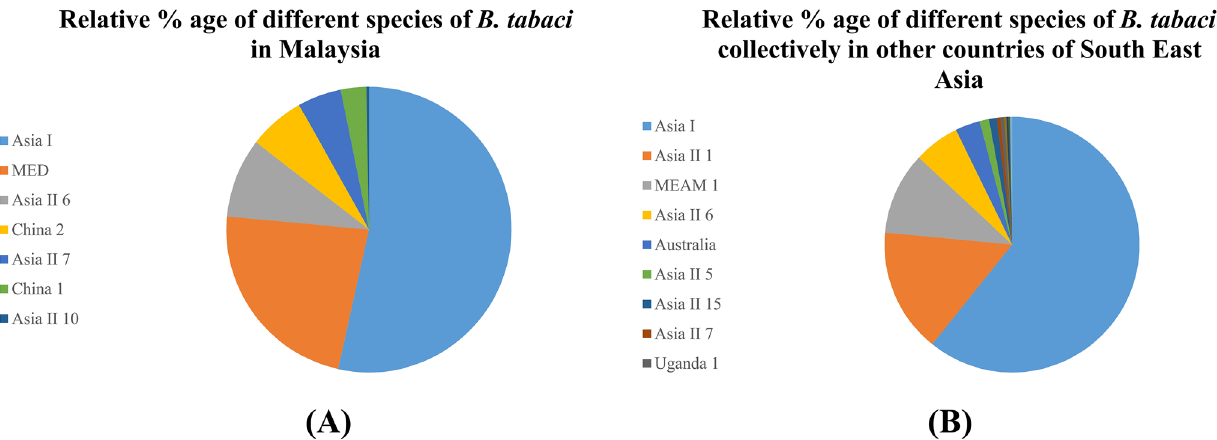
Figure 7. Bemisia tabaci species distribution in South East Asia. (A) The relative % of each species of B. tabaci so far reported from Malaysia, (B) shows the relative % of different species of B. tabaci collectively reported from other countries in South East